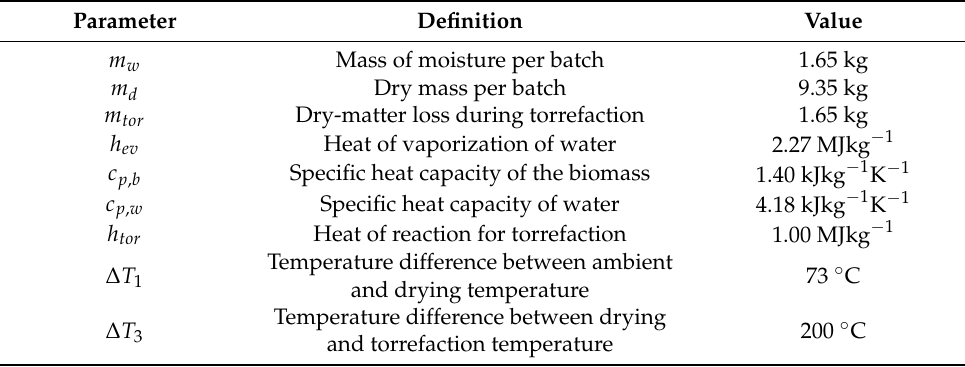
Table 1. Parameters used in the estimation of heat energy